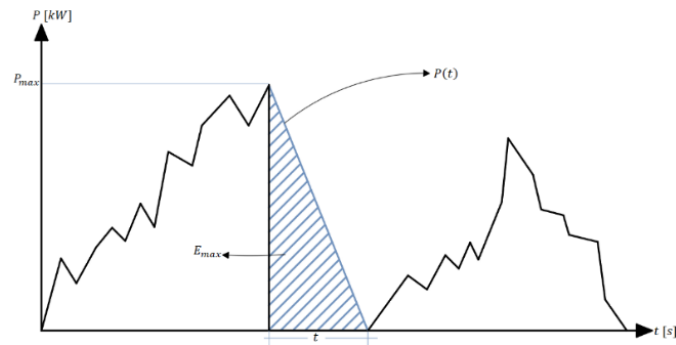
Figure 7. Behavior of the worst scenario of the PV solar system.